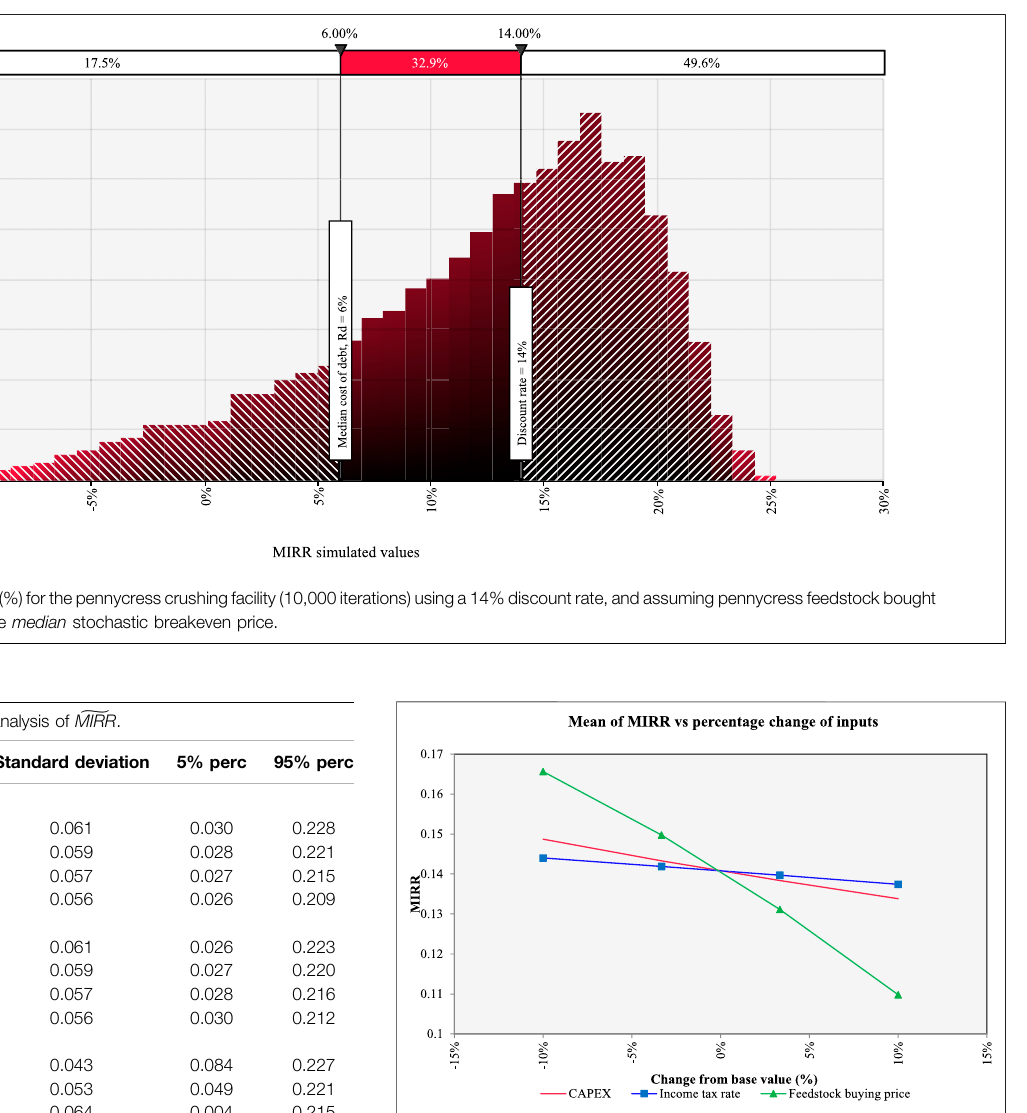
FIGURE 5 | Stochastic sensitivity graph. Notes: Mean of MIRR (vertical axis) vs percentage change of selected inputs (CAPEX, income tax rate, and feedstock buying price) at 14% discount rate, the most likely estimated discount rate. Simulations performed with the Advanced Sensitivity Analysis tool of @RISK ®